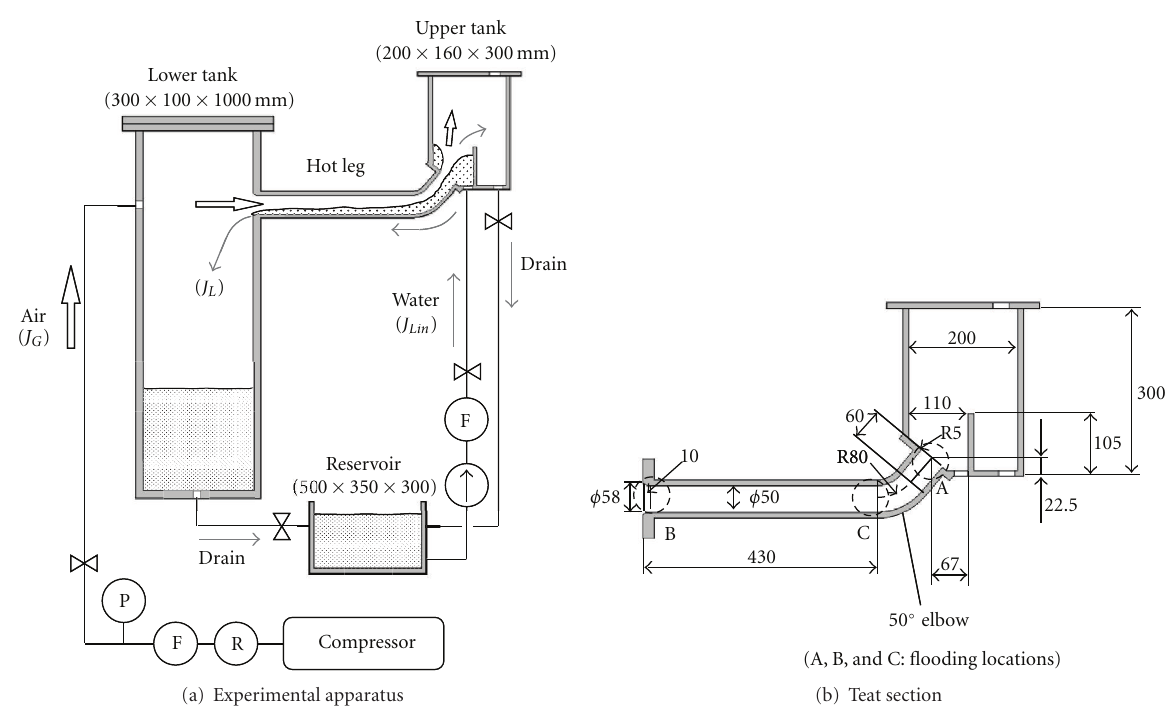
Figure 1: Experimental apparatus and test section used by Minami et al. [8] (unit: